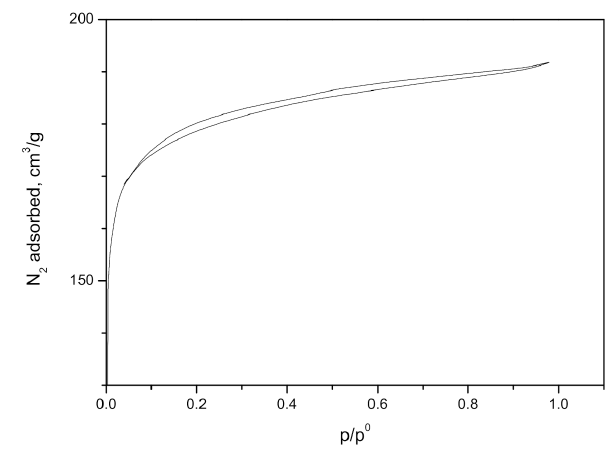
Figure 1. N 2 sorption isotherm activated carbon foam sample at − 196 ◦ C.